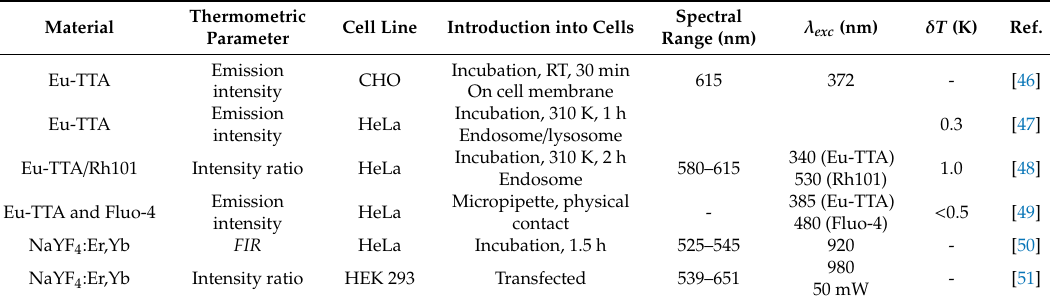
Table 2. Cellular thermometry using lanthanide-doped